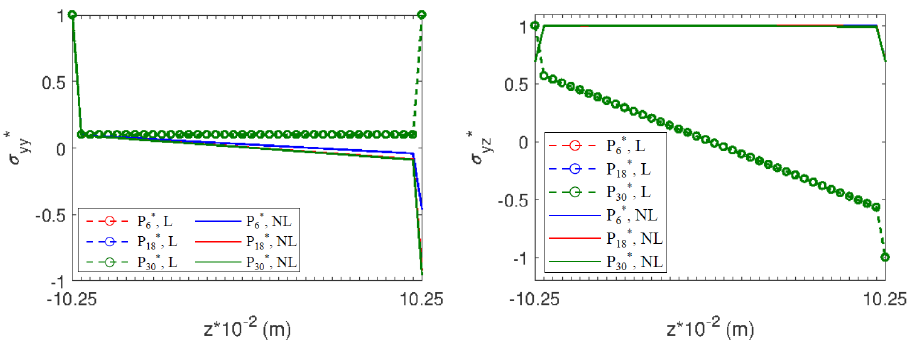
Figure 19. Distribution of axial and shear stress components for P ∗ = − 0.126, P ∗ = − 0.155, and P ∗ = − 0.169 values in L9 extensions at x = − a 2 /2 and y = L /2 in the the two-cell compos- ite beam subjected to axial loading; σ ∗ yy = σ yy / σ yy